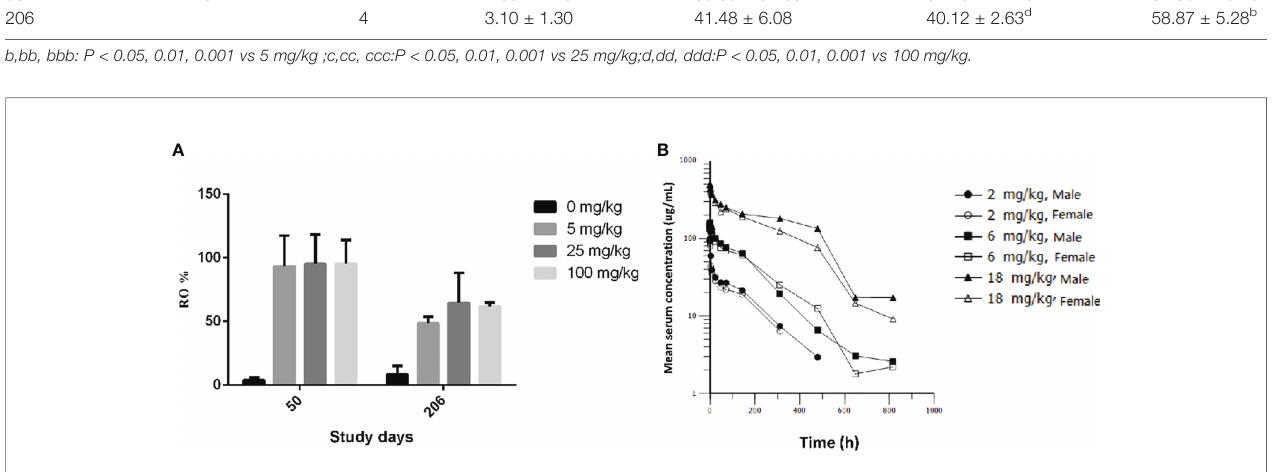
FIGURE 6 | PD-1 receptor occupancy and pharmacokinetic pro fi les of GLS-010 in cynomolgus macaques. (A) PD-1 receptor occupancy rate of activated CD3 + T cells of different doses of GLS-010 in cynomolgus macaques on day 50 and day 206. (B) Pharmacokinetic pro fi les of different doses of GLS-010 divided by sex in cynomolgus